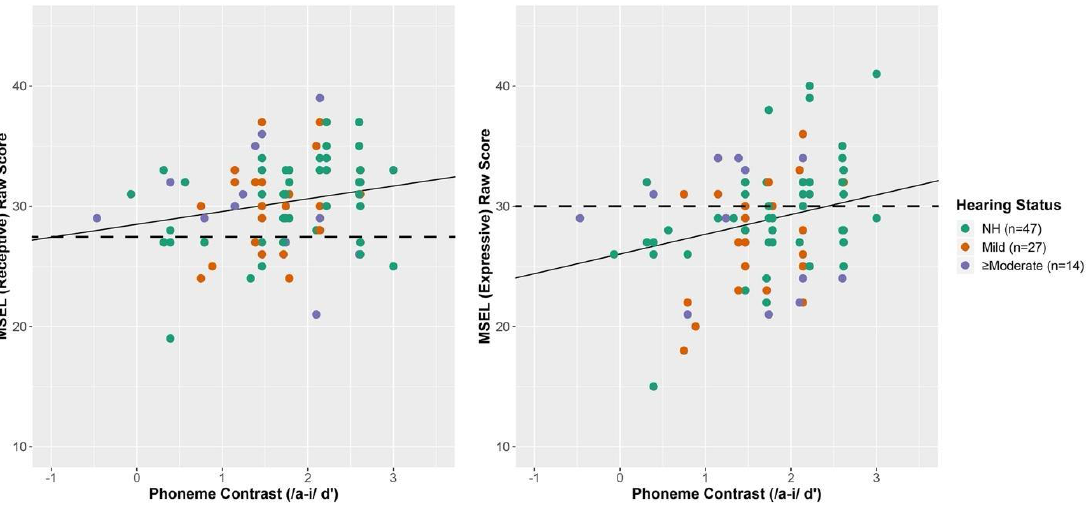
Figure 3. Speech discrimination and maternal level of education as predictors of spoken receptive and expressive language Note. Speech discrimination for the /a-i/ contrast measured in d’ is shown for listeners on the x-axis and receptive ( left panel ) and expressive ( right panel ) spoken language on the y-axis. The regression line was calculated for the mean value of maternal level of education. The dotted line represents the 50th percentile of the age-referenced score. Only 47 of 49 CNH were able.